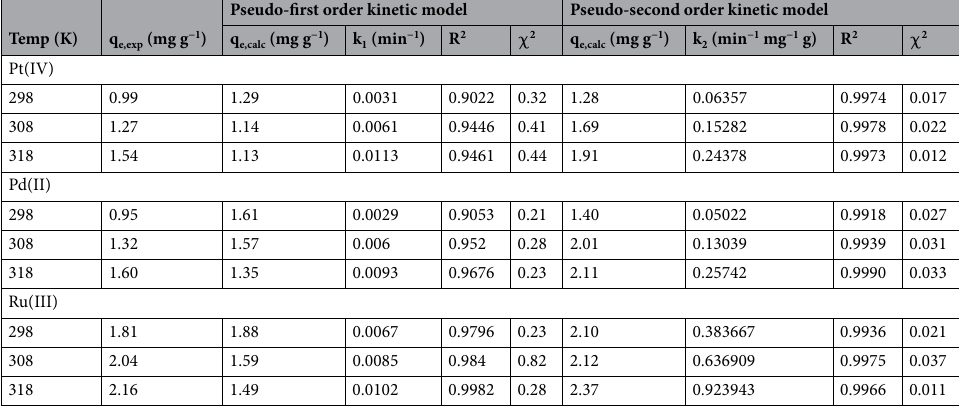
Table 3. Kinetic parameters for adsorption of Pt(IV), Pd(II) and Ru(III) onto Ch-DB18C6 material.